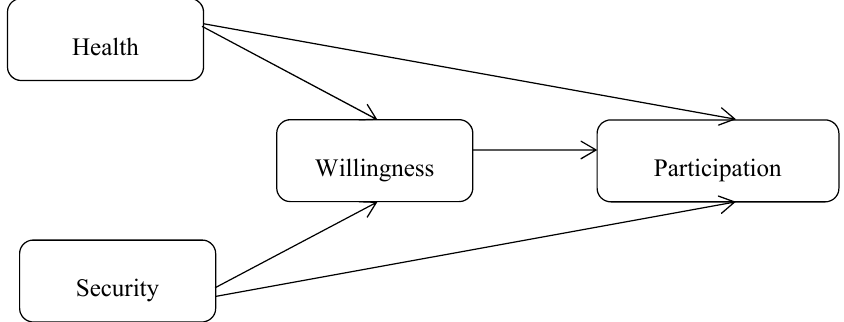
Figure 1. Theoretical structural relationship model for the three pillars of Active Ageing.